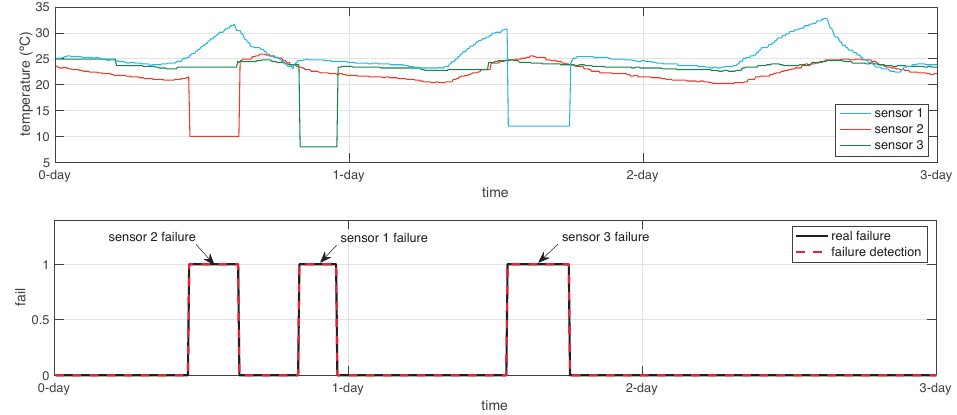
Figure 15. Failure detection response in the